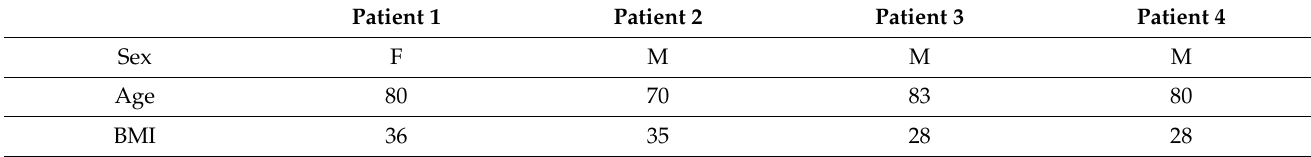
Table 1. Patients